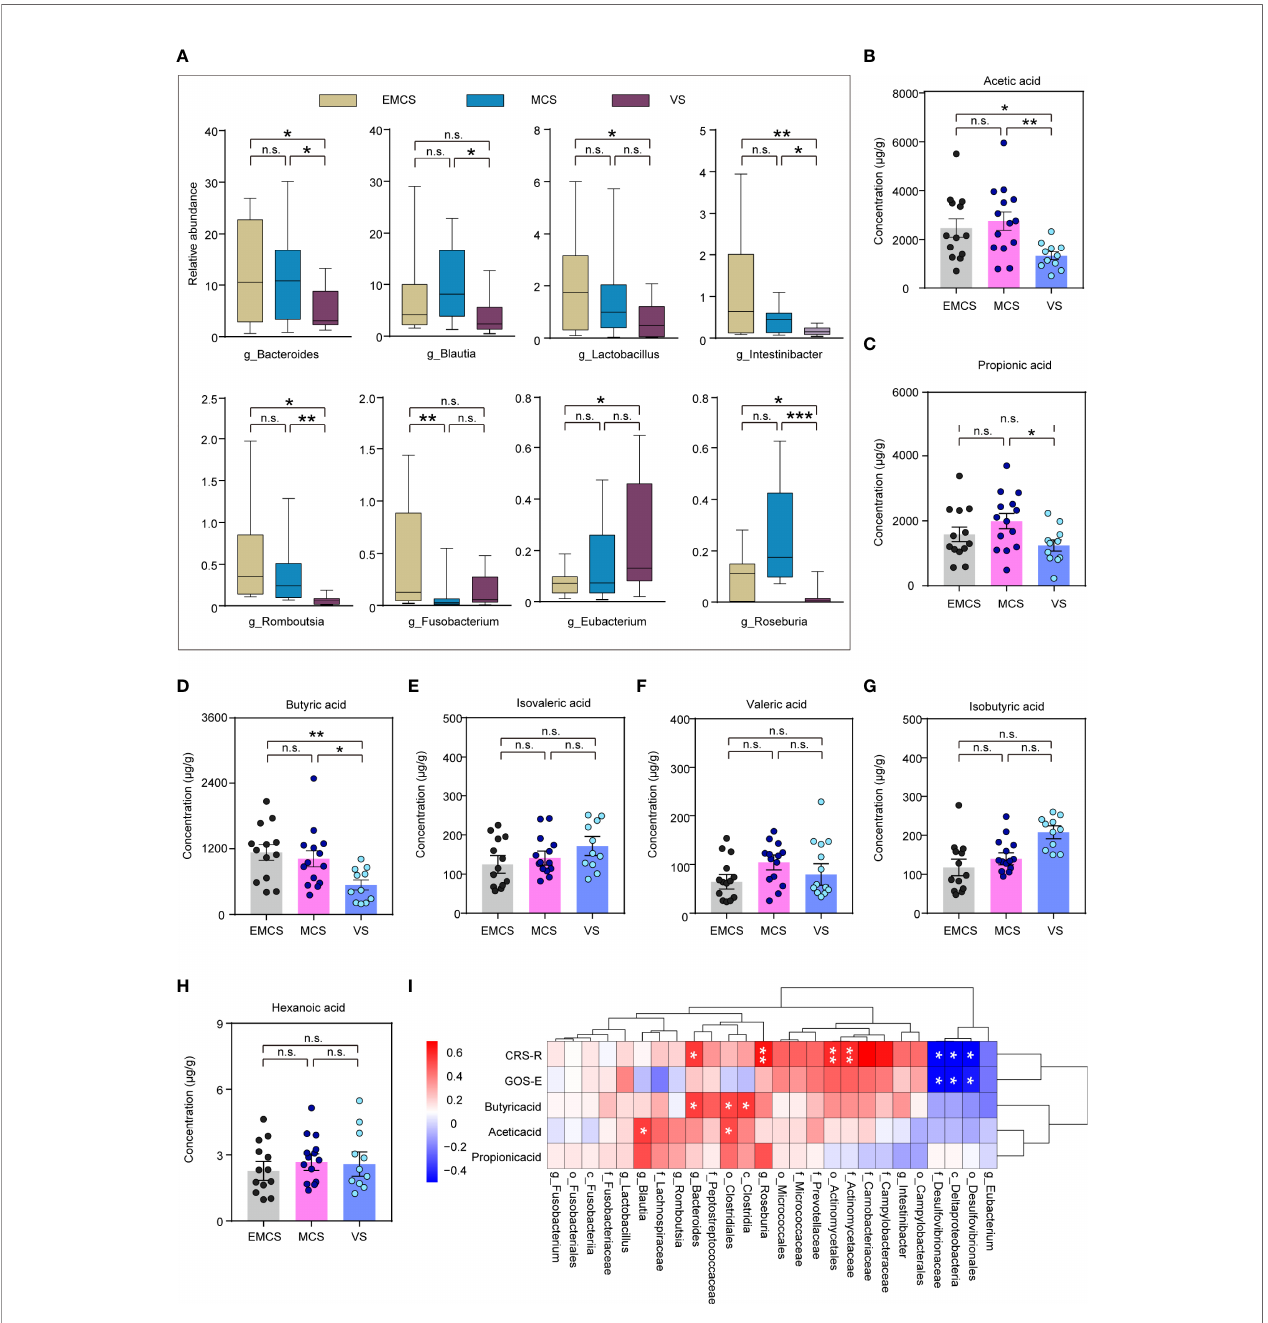
FIGURE 3 | Taxonomic differences at the genus level and differences in the short-chain fatty acids (SCFAs) in the fecal microbiota of EMCS, MCS, and VS patients. (A) Comparison of the relative abundance at the genus level across the three groups. Each box represents an interquartile range ( fi rst and third quartiles) of taxon abundance, and the middle line corresponds to the median abundance. P -values were corrected using FDR. (B – H) Comparison of the concentrations of the differential fecal SCFAs across the three groups. Data represent the mean ± SEM. (I) Heatmap of Spearman ’ s rank correlation analysis between the altered fecal microbiota and SCFAs and the CRS-R scores. Red indicates positive correlation and blue denotes negative correlation. P -values were determined using one-way ANOVA or the Kruskal – Wallis test. * p < 0.05, ** p < 0.01, *** p < 0.001; n.s. , no signi fi cant difference. g , genera; CRS-R , Coma Recovery Scale — Revised scores; GOS-E , Glasgow Outcome Scale — Extended; EMCS , emerged from minimally conscious state; MCS , minimally conscious state; VS , vegetative state; FDR , false discovery